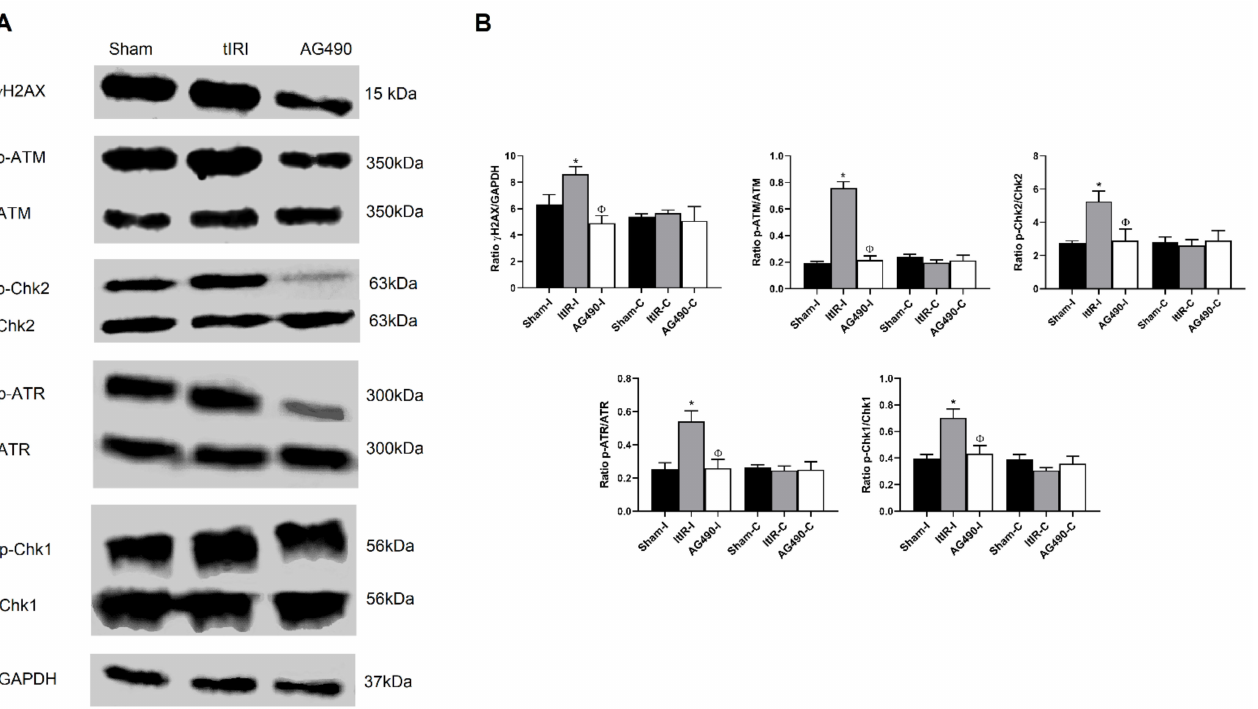
Figure 6. Modulation of the DDR pathways by JAK2 signaling. ( A ) Representative Western blots showing changes in the phosphorylation levels of γ H2AX, ATM, Chk2, ATR and Chk1. ( B ) Testes subjected to tIRI showed a marked elevation in the expression of γ H2AX, p-ATM, p-Chk2, p-ATR and p-Chk1 compared to sham ( p = 0.0470, p = 0.0002, p < 0.0001, p < 0.0001, respectively), while treatment with AG490 (40 mg/kg) resulted in a considerable decrease in their expression compared to tIRI levels ( p = 0.0051, p < 0.0001, p = 0.0002, p < 0.0001, respectively). Contralateral testes in all groups showed similar protein expression with no significant differences ( p < 0.05), which are presented in Supplementary Figure S1. Data are presented as mean ± SD ( n = 3/group). * tIRI compared to sham, Φ AG490 compared to tIRI. I = Ipsilateral and C =